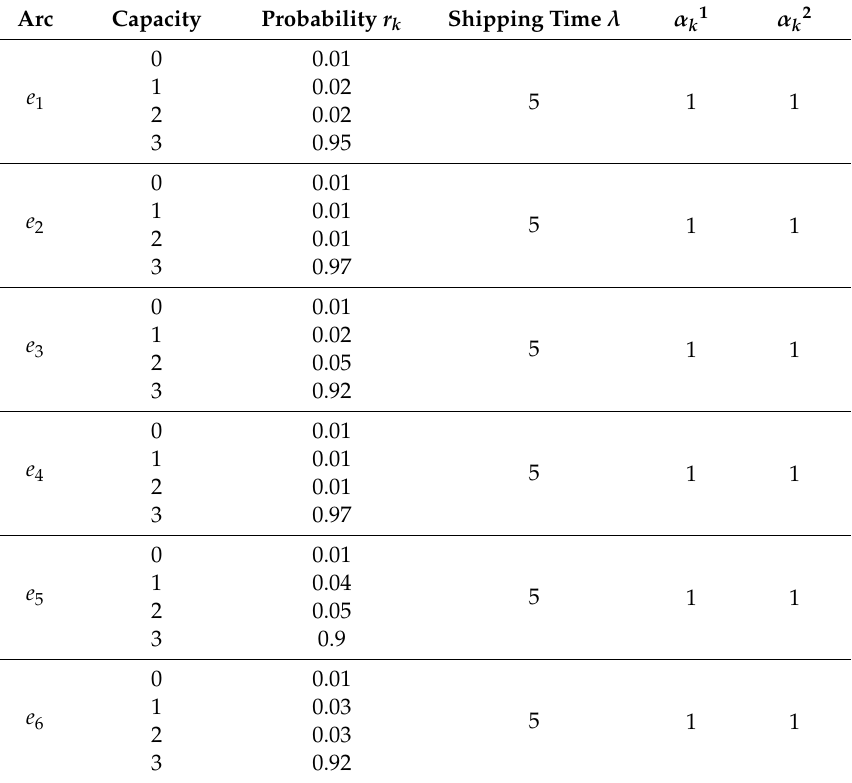
Figure 3. Network diagram example. Table 1. Basic data of each